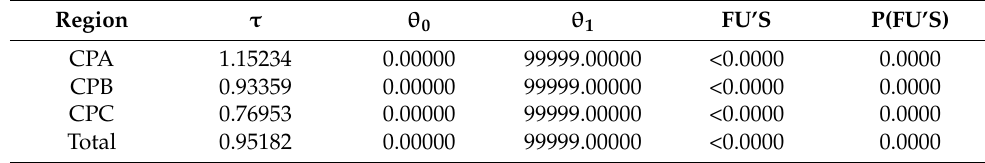
<0.0000 denotes a highly negative